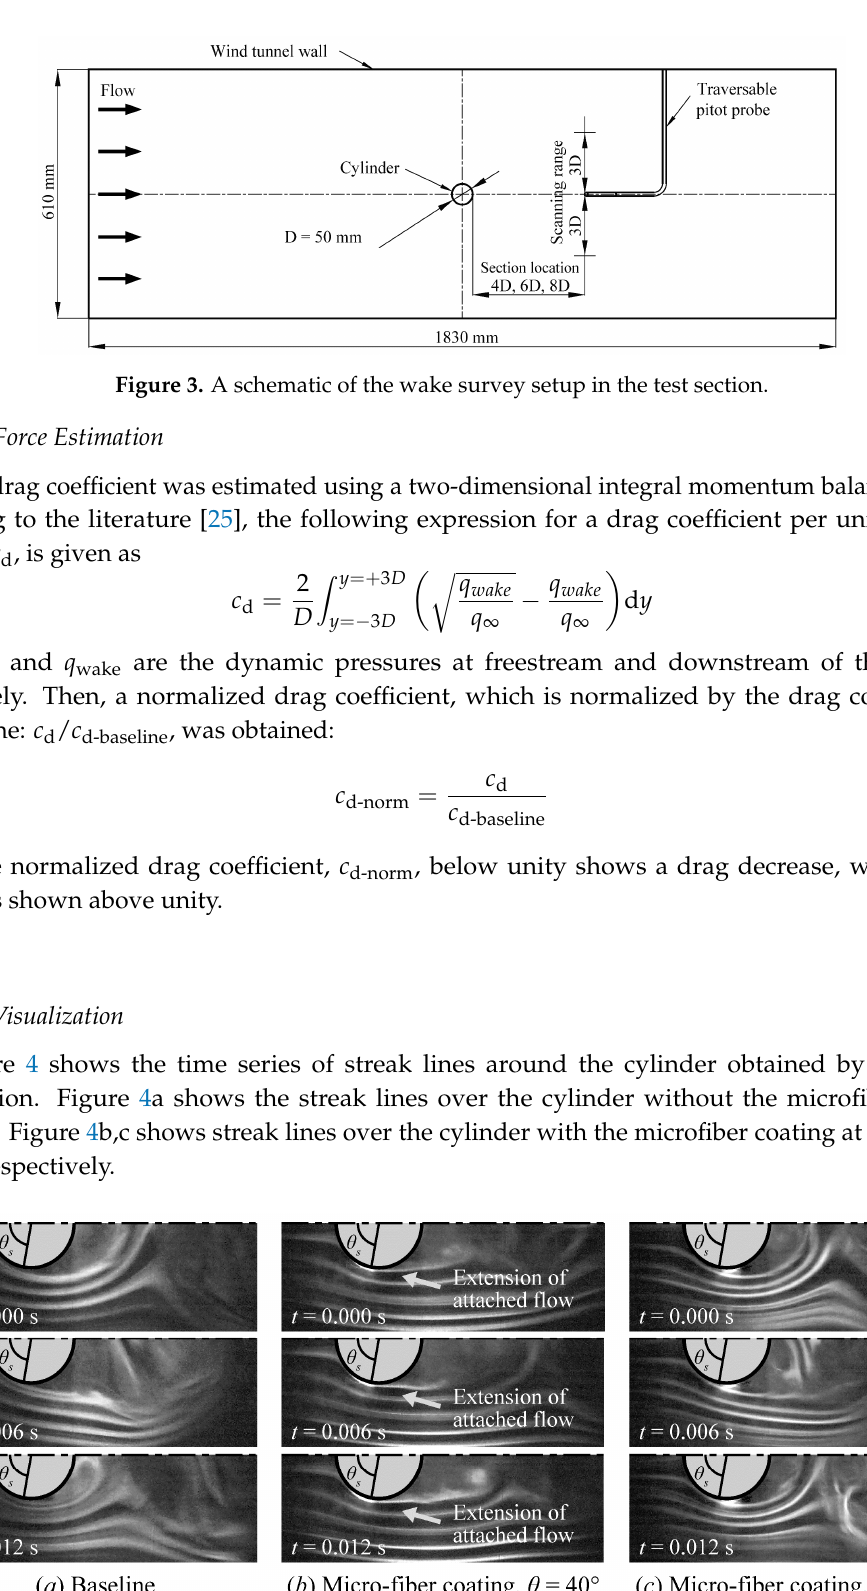
Figure 3. A schematic of the wake survey setup in the test section.